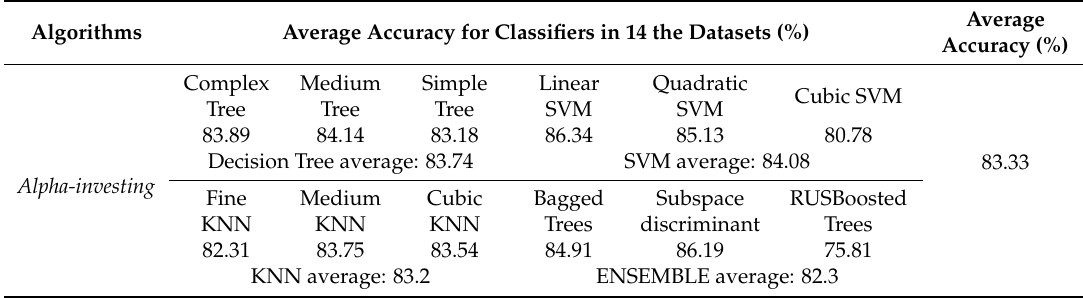
Table 5. Comparison of average prediction